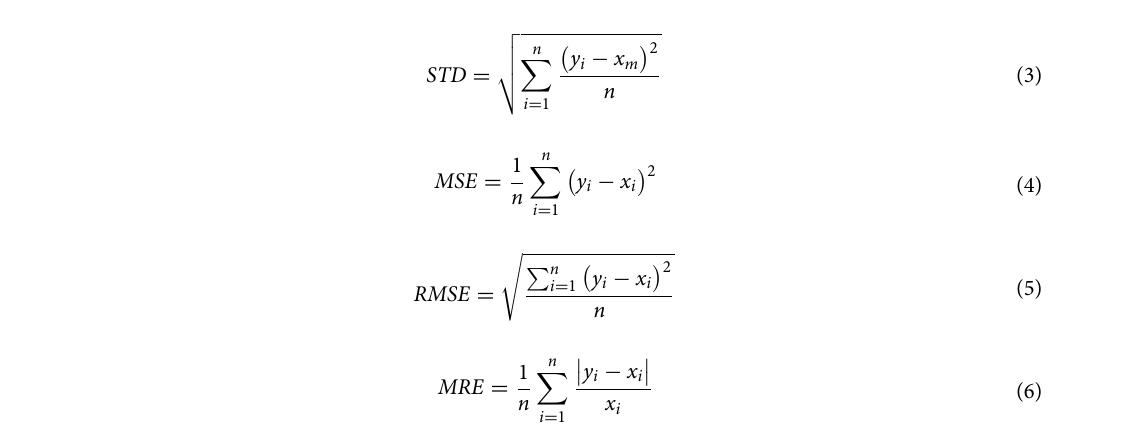
Figure 1. Steps and analysis parameters through the